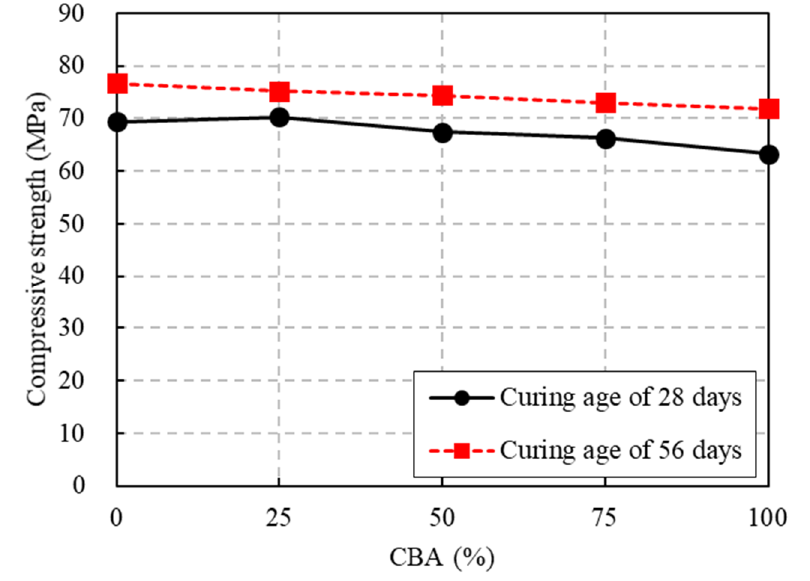
Figure 9. Compressive strength test results.